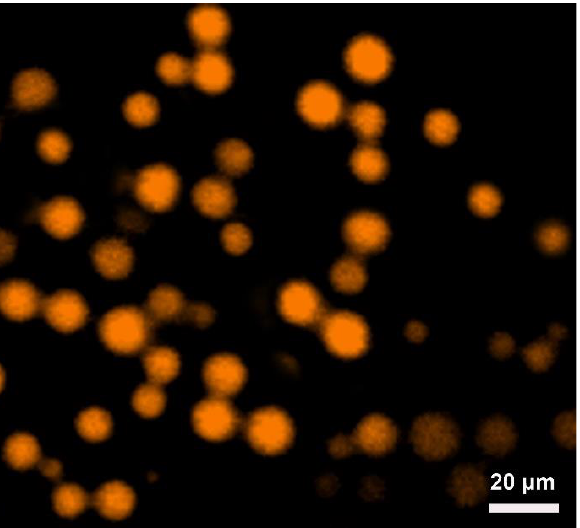
Figure 6. CLSM image of 1.0 wt% DC-Fe 3 O 4 nanoparticles stabilized liquid paraffin in water Pickering emulsion. The liquid paraffin (stained by Nile Red) and water were in an equal volume ratio.